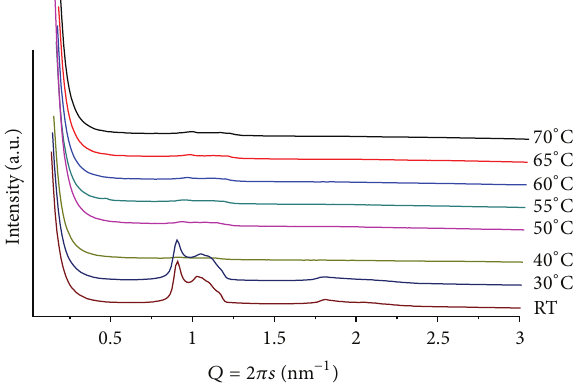
Figure5:SAXSpatternsatdifferenttemperaturesforPOPC/BANQ, mr = 50 and pH = 4